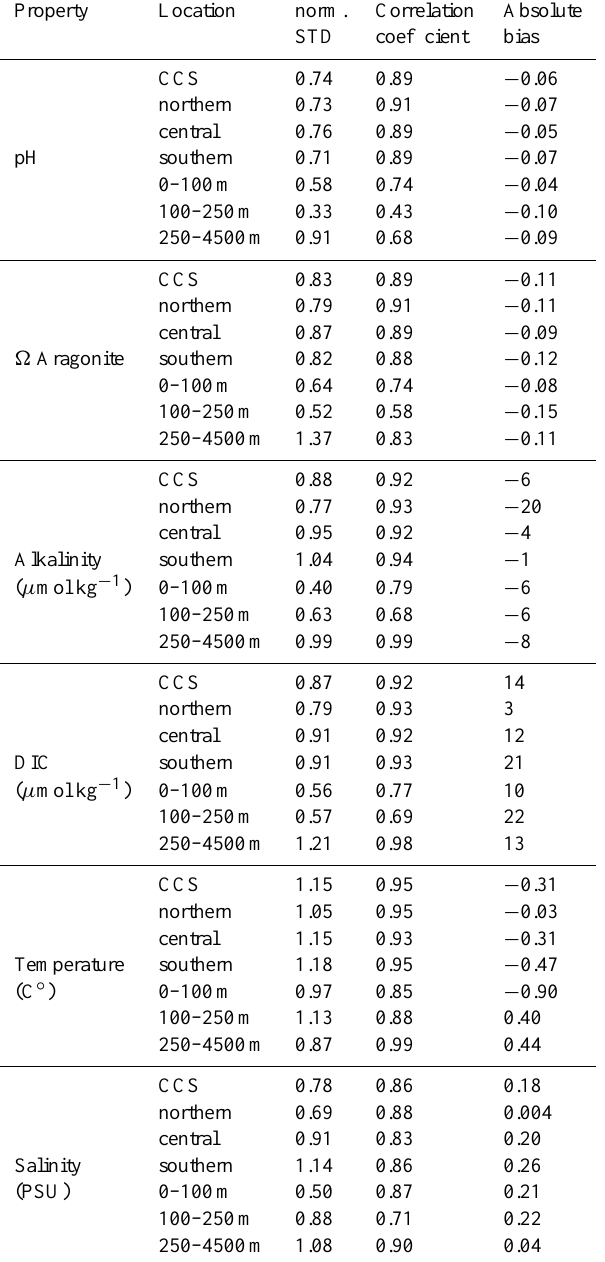
Table A2. Evaluation of model with regard to its spatial variability: Shown are the normalized model standard deviation (norm. STD.), the correlation coefficient and bias of observed and modeled pH, (cid:127) arag , Alkalinity, DIC, Temperature and Salinity. A five-year aver- age of modeled parameters over May and June (2006–2010) are compared to observations sampled between May and June 2007 (Feely et al., 2008), for all sampled locations (CCS), the subregions north, central, southern, for 0–100m, 100–250m and 500–5000m. The modeled standard deviations were normalized relative to the observed standard deviations from Feely et al. (2008). Specified units correspond only to the absolute bias.